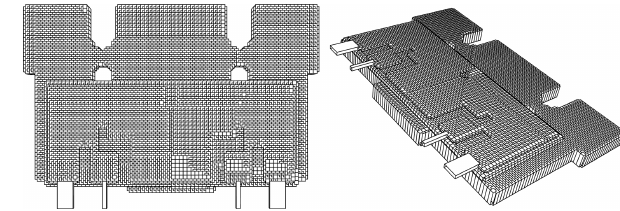
Figure 1. Fast Henry (Kamon et al., 1996) 3-D simulation model of a typical 5m (cid:127) foil shunt with resistance foil, carrier plate and mounting body.